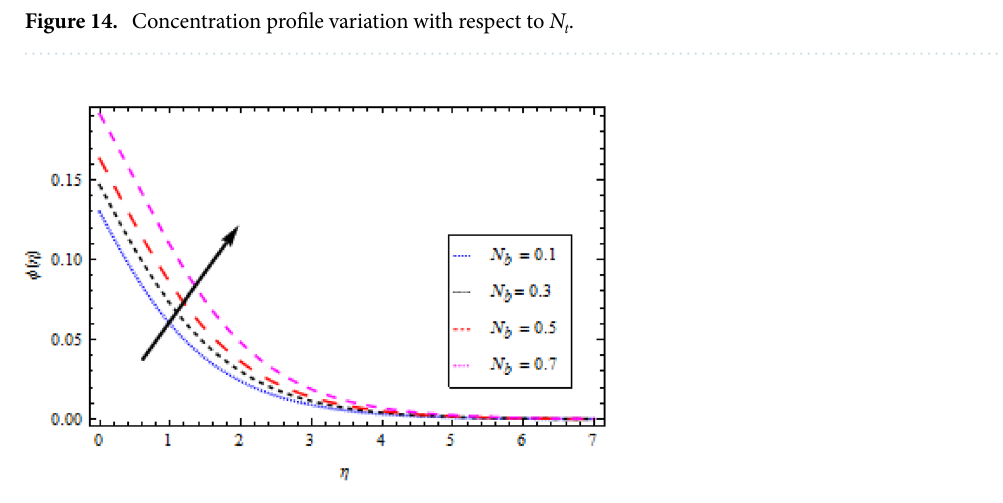
Figure 15. Concentration profile variation with respect to N b